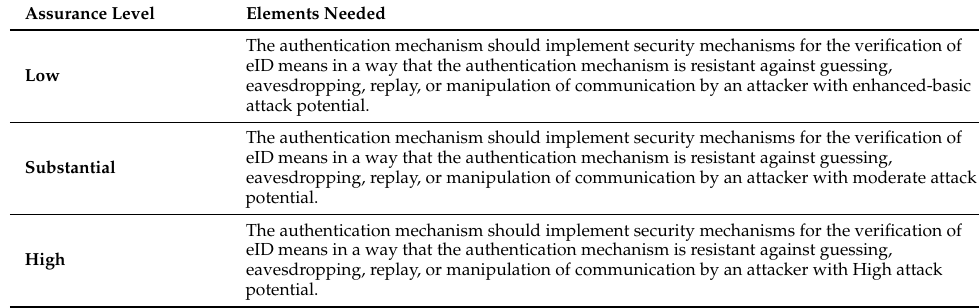
Table A1. Regulation 1501/2015 [2] Requirement per each